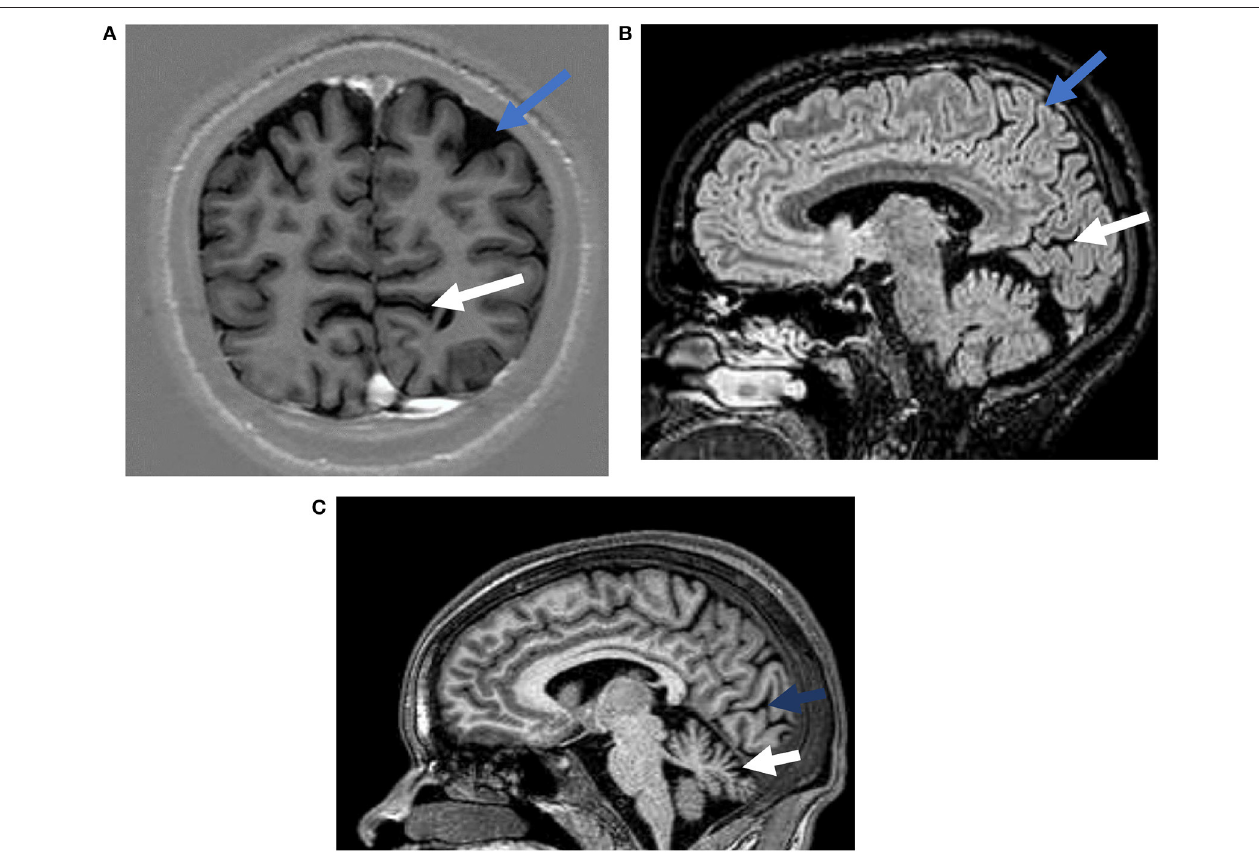
FIGURE 3 | Representative magnetic resonance images from possible OAE epilepsy cases. (A) A T1 weighted inversion recovery image demonstrating occipital atrophy (white arrow) and parietal lobe atrophy (blue arrow). (B) A T2 weighted FLAIR image demonstrating occipital (white arrow), and parietal atrophy (blue arrow). (C) A T1 weighted image showing occipital (blue arrow), and cerebellar (white arrow)